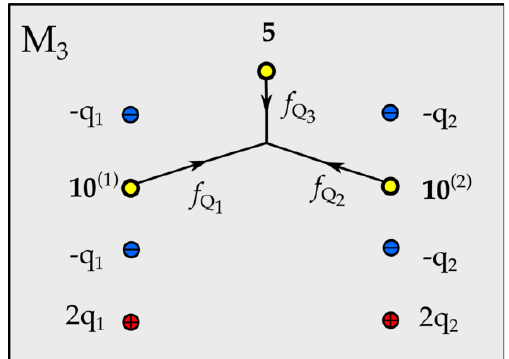
Figure 15 . The point charge distributions (cid:26) 1 and (cid:26) 2 with two types of U(1) charges (1) and (2). Negative charges (blue) and positive charges (red) add to zero for both con(cid:12)gurations and they each give rise to critical points (yellow) at which matter transforming in 10 (1) and 10 (2) is localized. The charge distribution (cid:26) 3 = (cid:0) (cid:26) 1 (cid:0) (cid:26) 2 gives rise to a third critical point (yellow) at which matter transforming in 5 resides. A (cid:13)ow tree between these 3 critical points gives rise to a Yukawa coupling of type 10 (1) 10 (2) 5